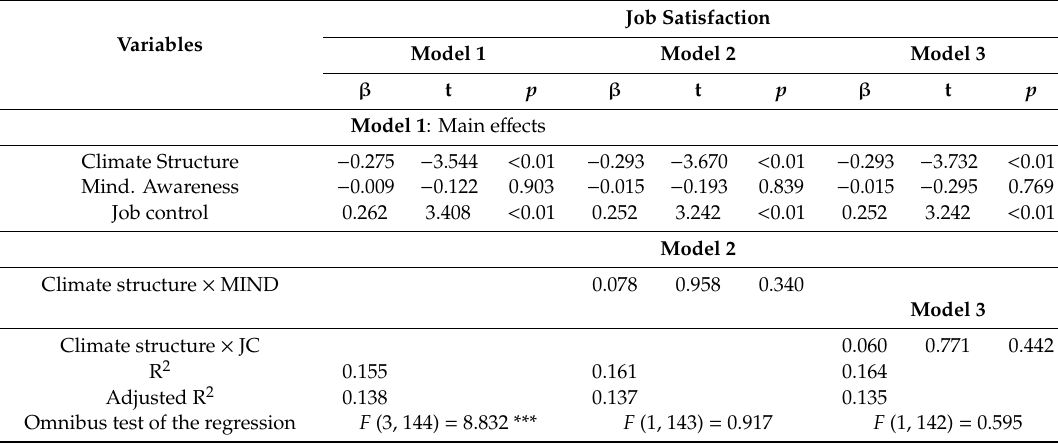
Table 4. Hierarchical regression analyses of the independent and interactive associations of sources of stress (FS—Climate, organizational), mindfulness Awareness, and job control (JC) with job satisfaction (using 1000 bootstraps) ( n =